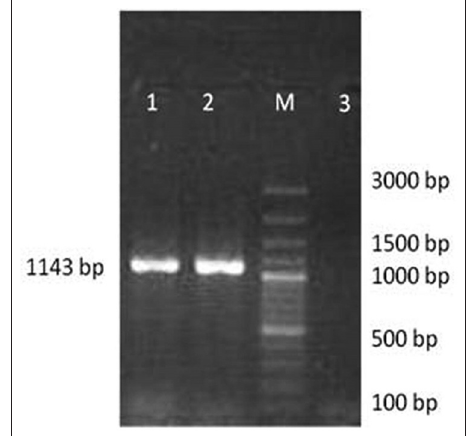
Figure-3: Confirmation of the recombinant clones by colony polymerase chain reaction: Lane M: 100 bp DNA Ladder, Lanes 1 and 2: nagH amplicon of 1143 bp size, Lane 3: Negative control.